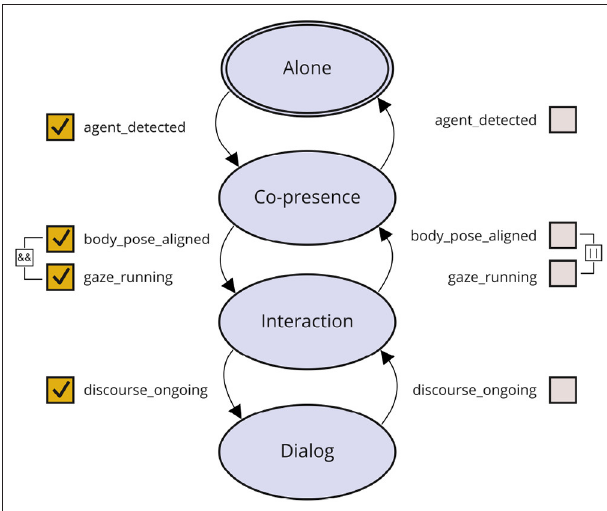
FIGURE 5 | State machine describing possible interaction modes along with their